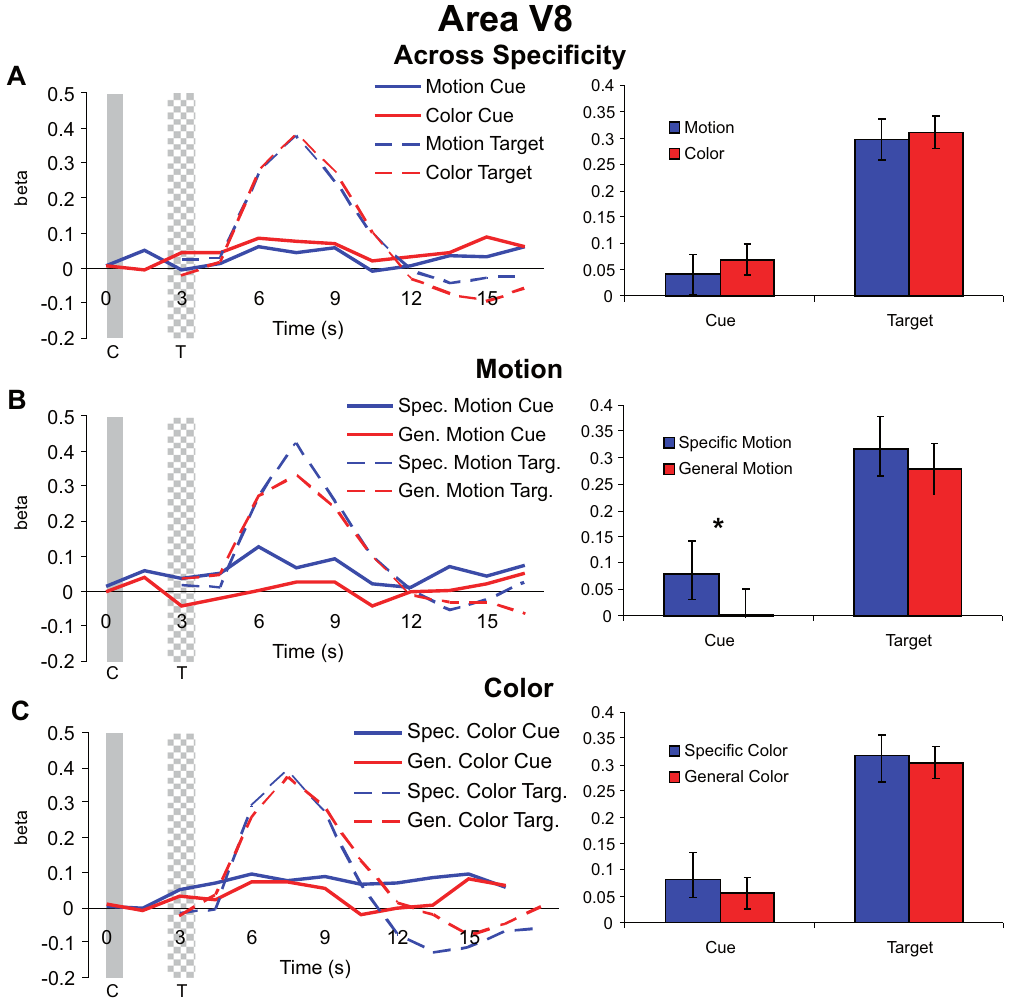
Figure 5. Cue and target responses in area V8. Left column shows BOLD response time course estimates (beta weights) in V8. The solid and checkered gray bars represent the cue and target presentations, respectively. The right column shows the amplitude of cue responses averaged over the three TRs centered on the peak of the hemodynamic responses (see “Materials and methods”). All individual target responses are signifi cantly different from the zero baseline. For the cue responses, although smaller than observed in MT, here in V8 the responses are also signifi cantly different from the zero baseline expect for the cue response in the general dimension motion trials (see panel B). (A) Hemodynamic responses collapsed across specifi c feature and general dimension trials for motion and color cues and targets in V8. Unlike for MT (see Figure 4 ) there was no signifi cant difference in target processing with attention (attending for color vs. motion) in V8. (B) Hemodynamic responses for motion specifi c feature and general dimension cues and targets in V8. (C) Hemodynamic responses for color specifi c feature and general dimension cues and targets in